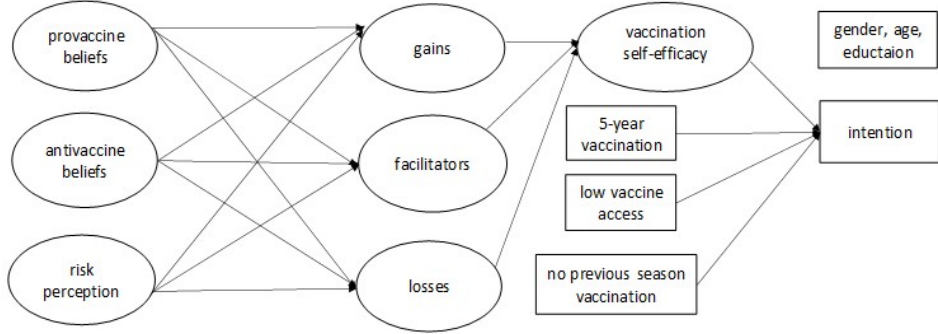
Figure 1. The conceptual model tested in the study.